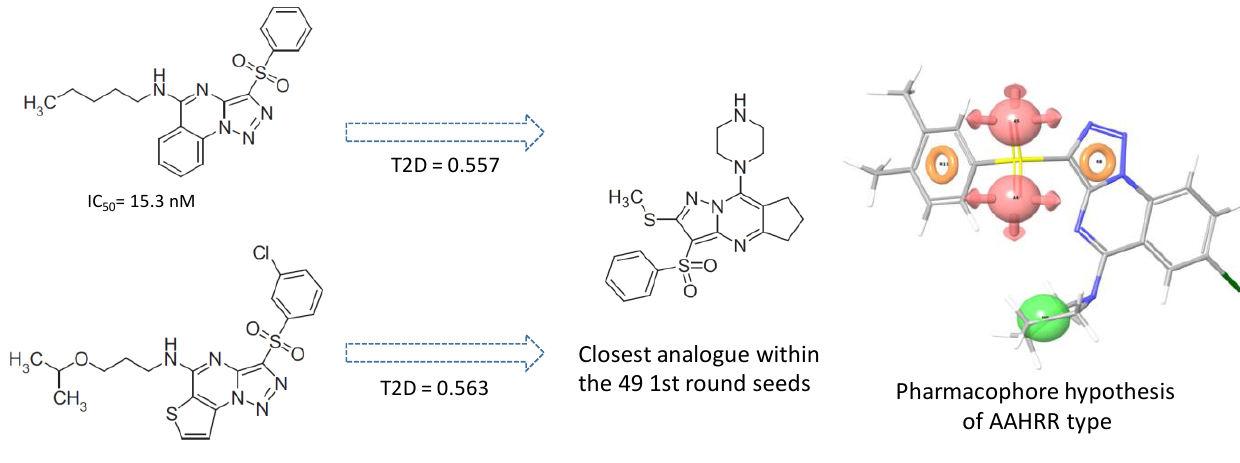
Figure 13. Pharmacophore model leading to novel chemotypes of 5 HT 6 antagonists. Two-dimensional similarity search (T2D ≥ 0.8) around the structure of the six first- round hits (IC 50 ≤ 1 µ M) gave better results in terms of the hit rate (27 compounds out of 56 were found active, hit rate = 51%, most active hit—IC 50 = 1.9 nM), and the average